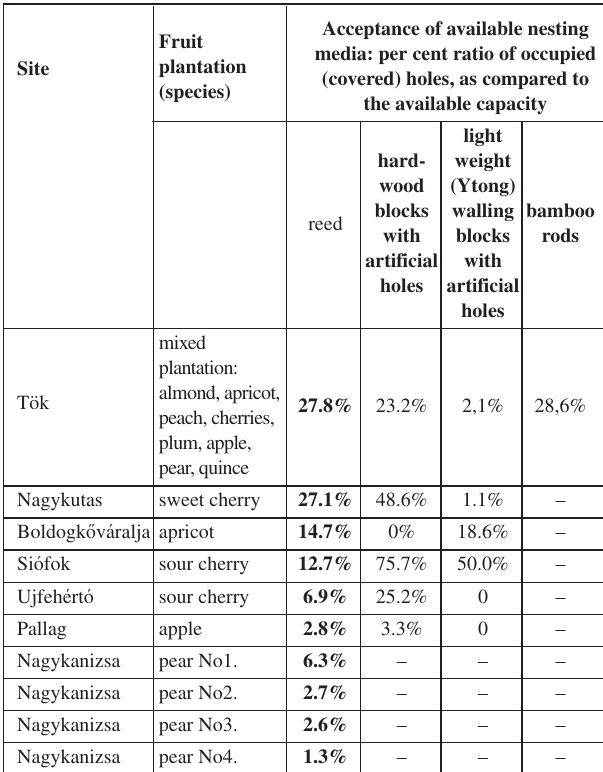
Table 1. Acceptance of artificial nesting media by early spring mason bees (mixed Osmia cornuta and O. rufa populations) in bee shelters placed at orchards of different fruit tree